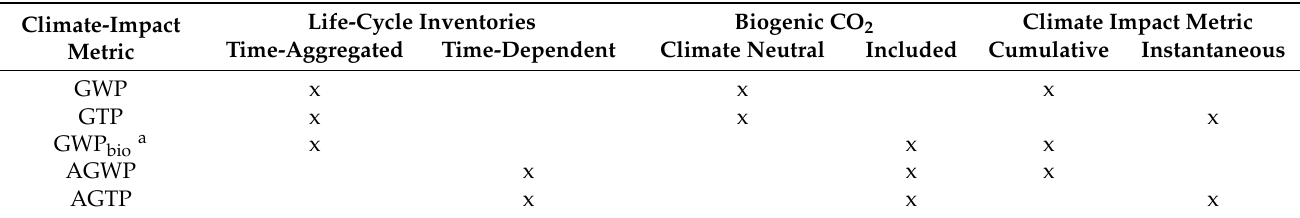
Table 1. Analytical approaches and assumptions used in this study, including type of climate impact metric, setup of life-cycle inventories, and assumption for biogenic CO 2 (carbon dioxide). Climate-Impact